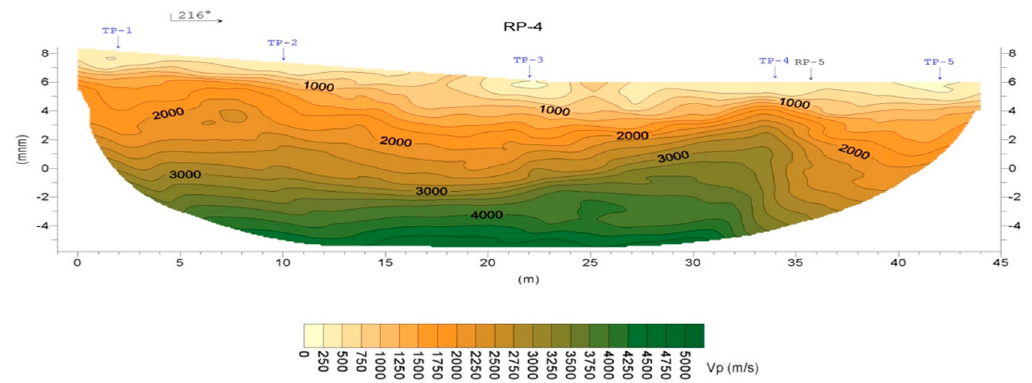
Figure 11. Refraction profile on location of the Kantrida swimming pool, from [54].